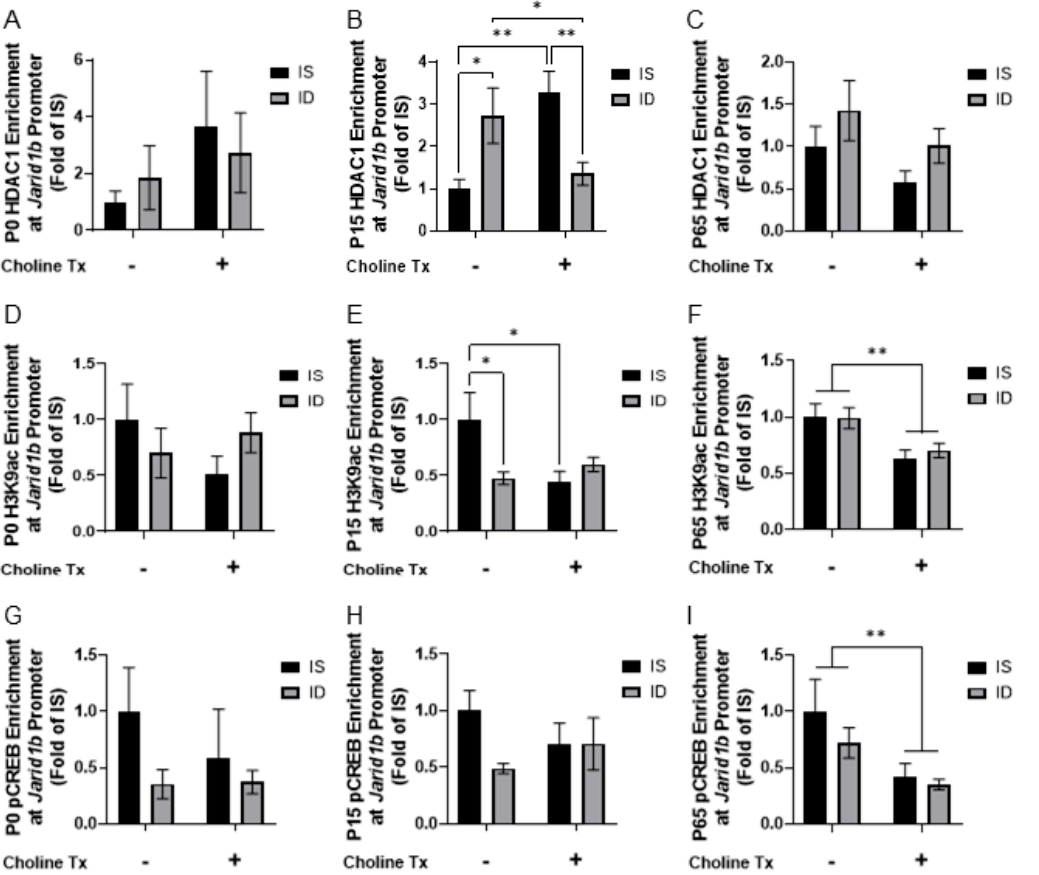
Figure 3. Iron deficiency and choline supplementation alter rat hippocampal Jarid1b regulation. ( A – C ) HDAC1 enrichment at the Jarid1b promoter in the 4 groups at P0 ( A ), P15 ( B ), and P65 ( C ). ( D – F ) H3K9ac enrichment at the Jarid1b promoter in the 4 groups at P0 ( D ), P15 ( E ), and P65 ( F ). ( G – I ) Phosphorylated cAMP response element-binding protein (pCREB) enrichment at the Jarid1b promoter in the 4 groups at P0 ( G ), P15 ( H ), and P65 ( I ). All data were assessed with quantitative chromatin immunoprecipitation (qChIP) and normalized to the age-matched IS group. Tx: Treatment (Supplementation). Values are mean ± SEM, n = 5–6/group, * p < 0.05, ** p < 0.01.